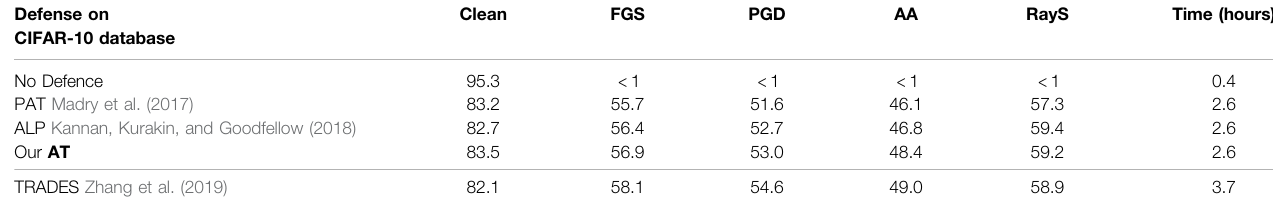
TABLE 1| Defenseagainst white-boxattack on CIFAR-10. Theadversarial perturbations were produced using FastGradient Sign(FGS) Goodfellow et al.(2015), Projected Gradient Descent (PGD) Madry et al. (2017), AutoAttack (AA) Croce and Hein (2020) and RayS Chen and Gu (2020). The perturbation magnitude is ϵ (cid:1) 8/255 under L ∞ norm.